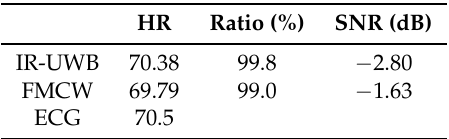
Table 5. HR Results of Carotid Pulse measurements.